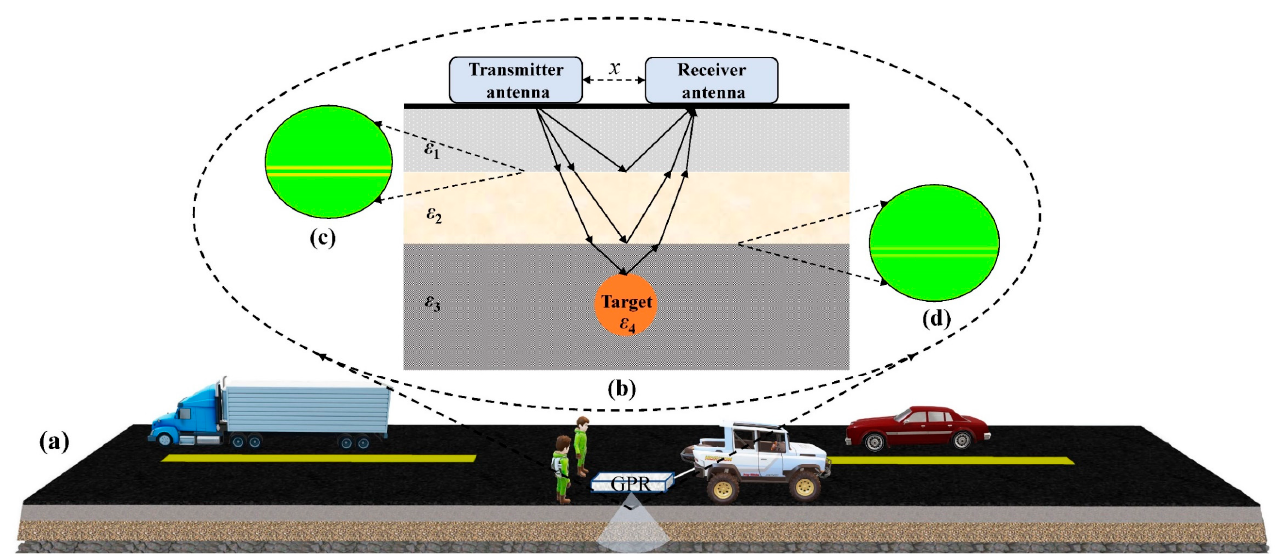
Figure 5. Schematic diagram of the GPR survey on the highway: ( a ) highway; ( b ) the electromagnetic waves emitted by the transmitting antenna are reflected by the different layers and then return to the receiving antenna; ( c ) strong electromagnetic wave reflection; ( d ) weak electromagnetic wave reflection.